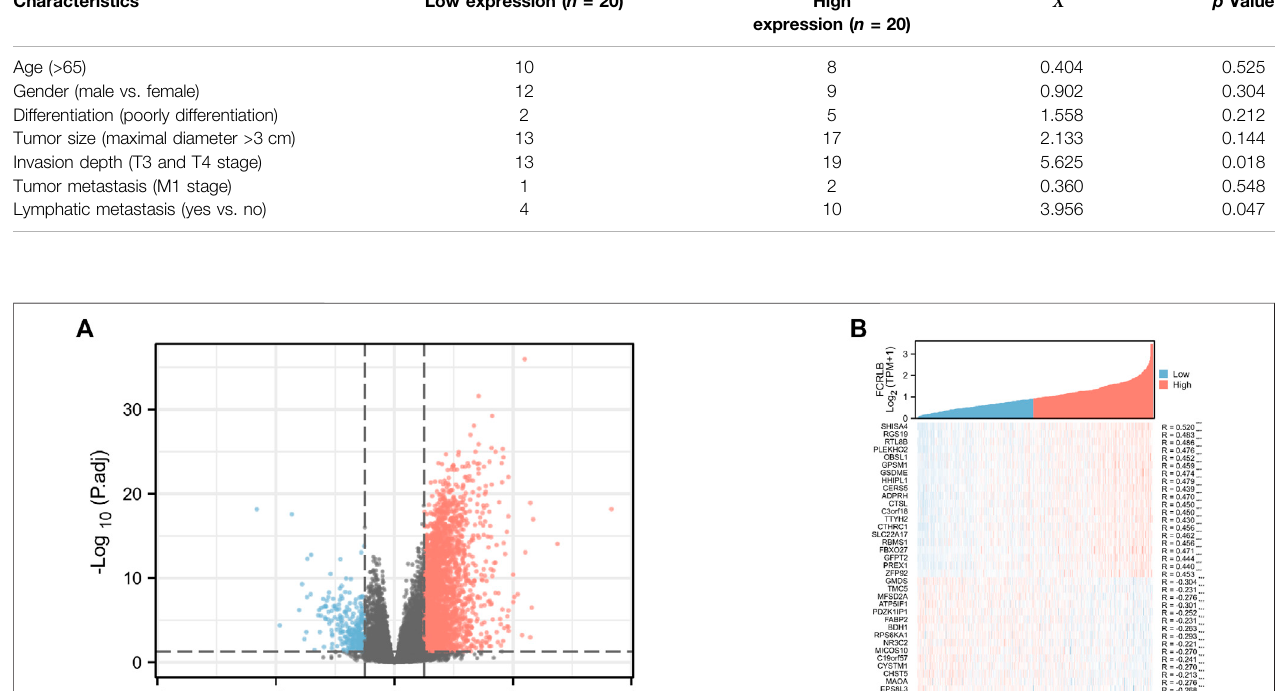
TABLE 2 | Clinicopathological factors and FCRLB expression in TMA. Characteristics